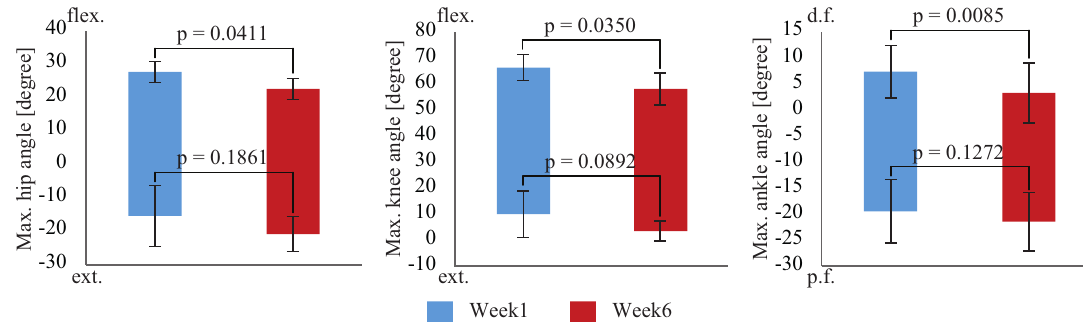
Figure 8. Comparison of maximum joint angles achieved in the POFF condition between Week 1 and Week 6. Here, flex.: flexion, ext.:extension, d.f.: dorsiflexion, and p.f.: plantar flexion. On each bar chart, the error bar denotes one standard